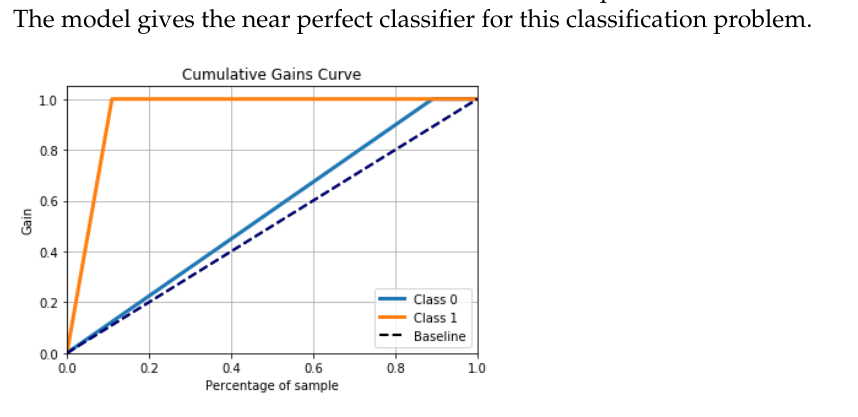
Figure 5. The cumulative gain curve of the CMB model (Class 0 is for “yes” label and class 1 is for “no”